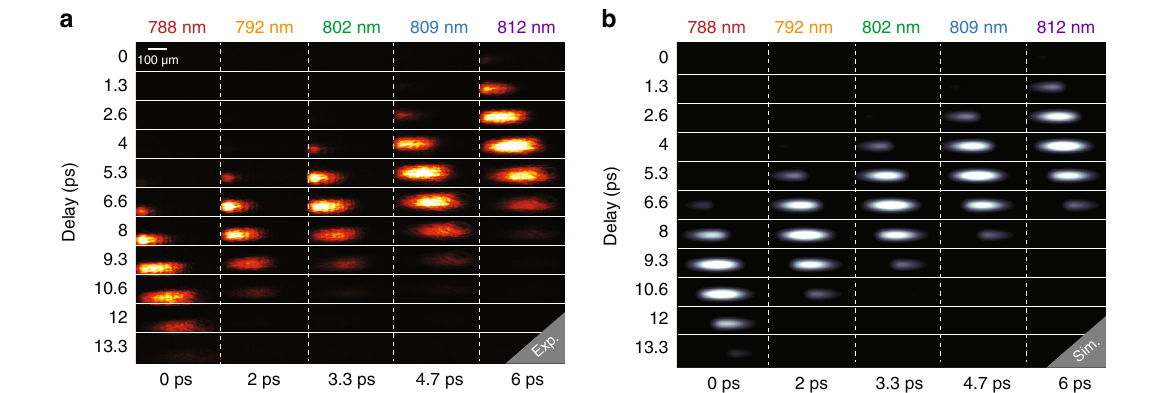
Fig. 4 Imaging of an optical Kerr gate (OKG) in the picosecond regime. a Vertically stacked images of the transmitted pulses while varying the optical delay. The opening and closing of the OKG are fully acquired for a delay of 6.6 ps. b Numerical simulation (see "Methods") of the OKG imaging